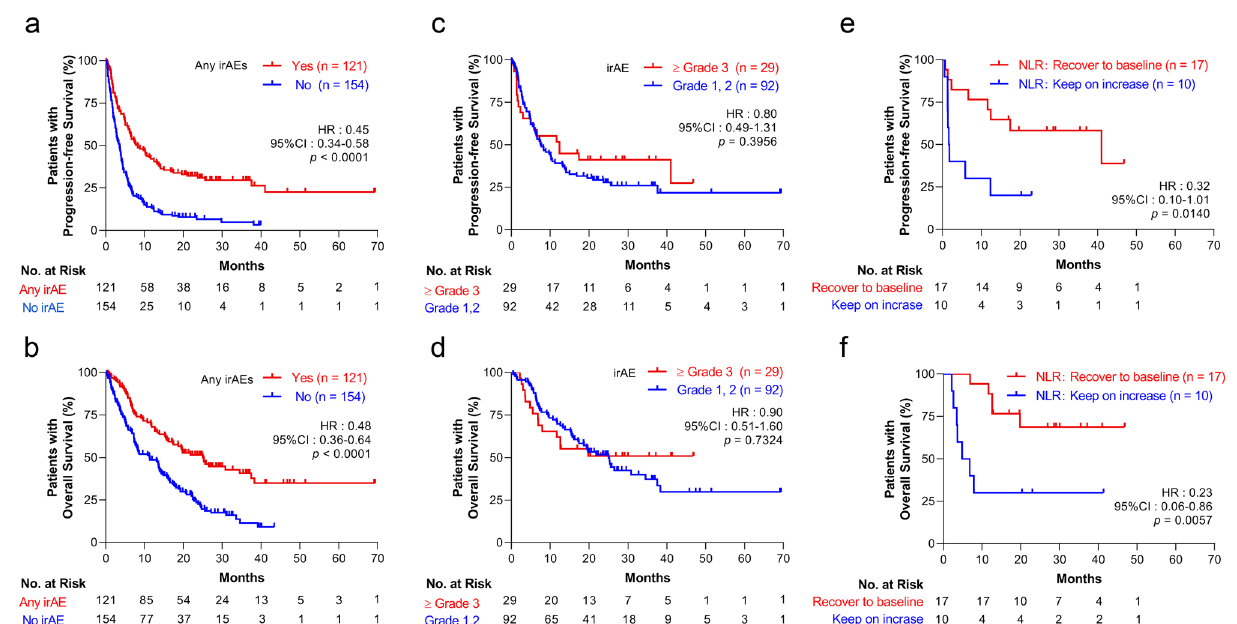
Figure 4. Trend in NLR estimates subsequent prognosis after severe irAE. ( a ) Kaplan-Maier analysis of PFS and ( b ) OS were performed in patients stratified according to the irAE incidence. ( c ) Among the patients with irAE development, PFS and ( d ) OS were investigated according to their irAE severity. ( e ) Among the patients who experienced Grade 3 or more severe irAEs, PFS and ( f ) OS were performed in patients stratified according to the NLR trend at 4 weeks after the development of the irAEs. Statistical analysis was performed using the log-rank test. NLR neutrophil-to-lymphocyte ratio, irAE immune-related adverse event, PFS progression-free survival, OS overall